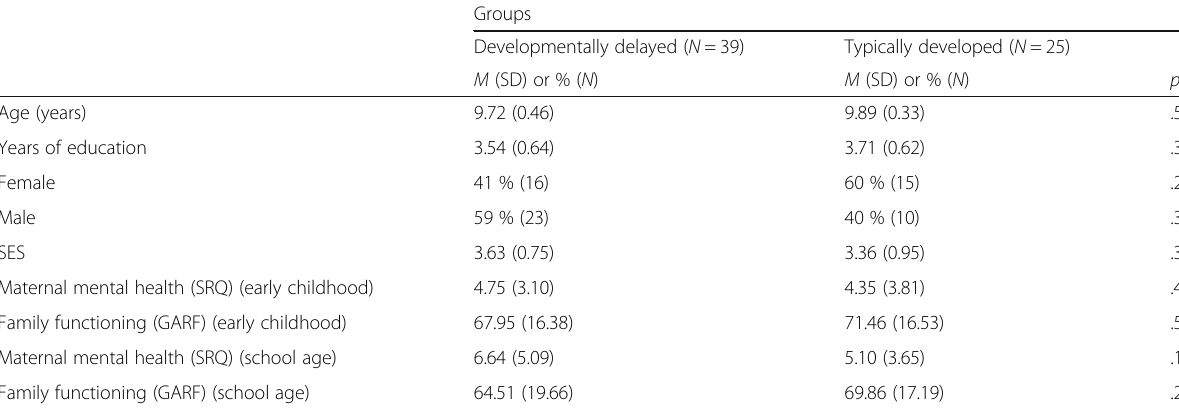
Table 1 Sample demographics ( N = 64)